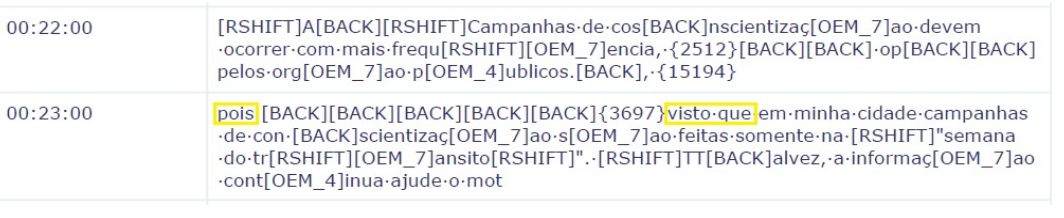
Figure 6 Transcription provided by